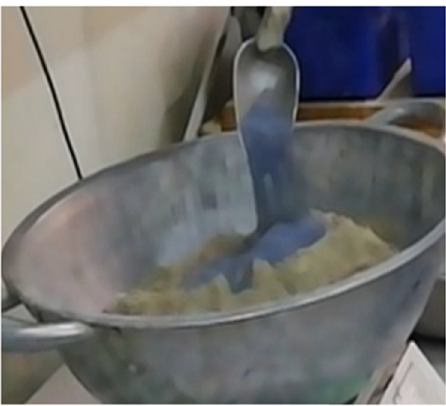
Figure 2: Silica fume.